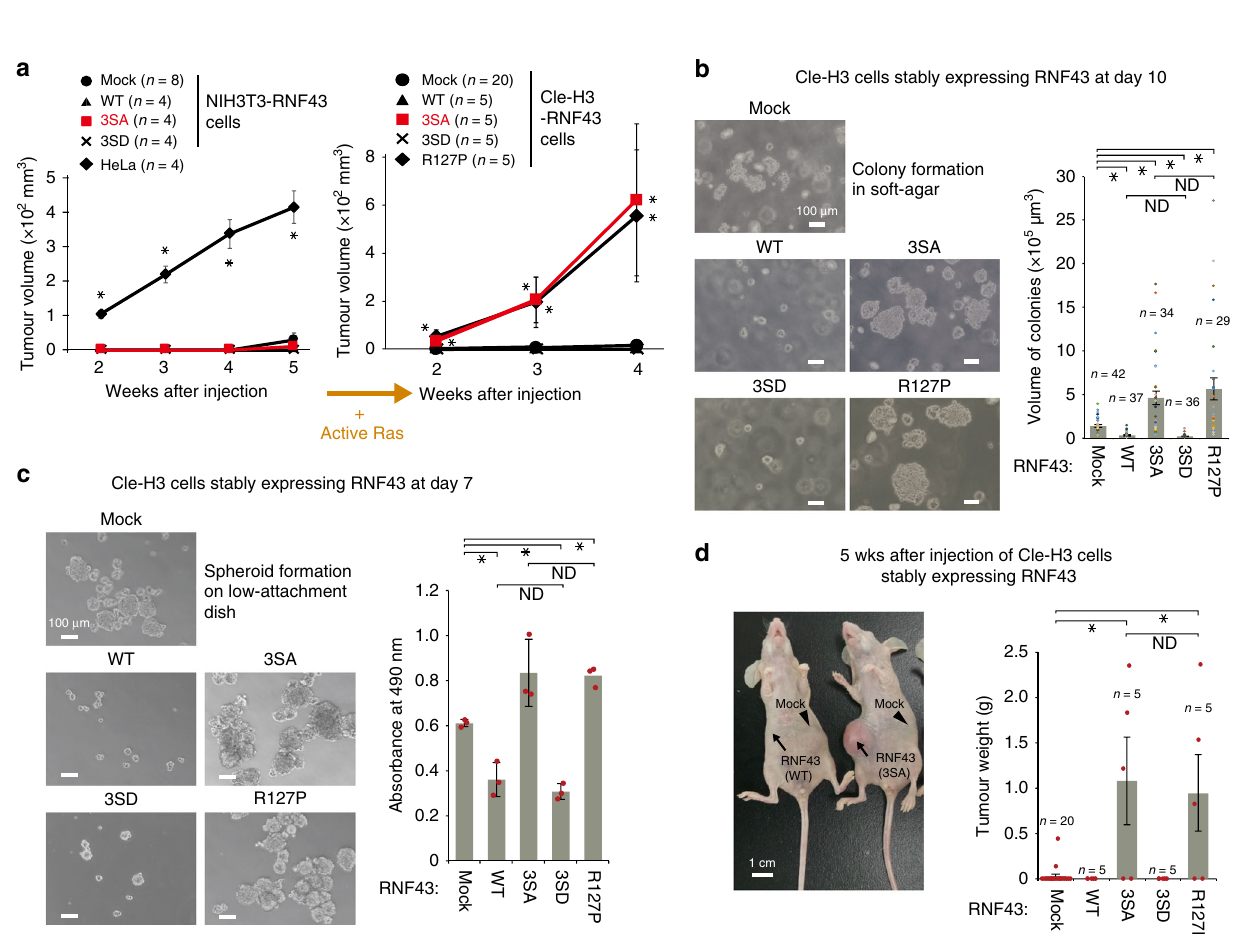
Fig. 4 Active Ras cooperates with mutant RNF43 to induce tumorigenesis. a Time-dependent tumour growth was examined in nude mice following expression of RNF43 phospho-mutant forms in NIH3T3 and Cle-H3 cells. Estimated tumour volume is shown. Red lines indicate RNF43(3SA)-expressing tumours. b Anchorage-independent colony-forming activity was evaluated via soft agar assay following the expression of RNF43 phospho-mutant forms in Cle-H3 cells. Scale bars, 100 μ m. c Spheroid-forming activity was examined in Cle-H3 cells expressing RNF43 mutant forms. Spheroid formation was quanti fi ed via MTS assay. d Image of nude mice injected with Cle-H3-RNF43 cells. Scale bars, 1 cm. Tumour weight was measured at 5 wks following Cle- H3 injection. Graphs and error bars in this fi gure represent mean ± sd ( c ) or ± standard error of the mean (sem) ( a , b , d ) of independent experiments or samples. Red circles indicate individual values of each sample b – d ). The P values for the indicated comparisons in this fi gure were determined by one-way ANOVA ( P < 0.05). n = 4 – 20 ( a ), n = 29 – 42 ( b ), n = 3 ( c ), n = 5 – 20 ( d ) biologically independent samples. Asterisks or ND indicates signi fi cant or no signi fi cant difference in indicated comparisons,